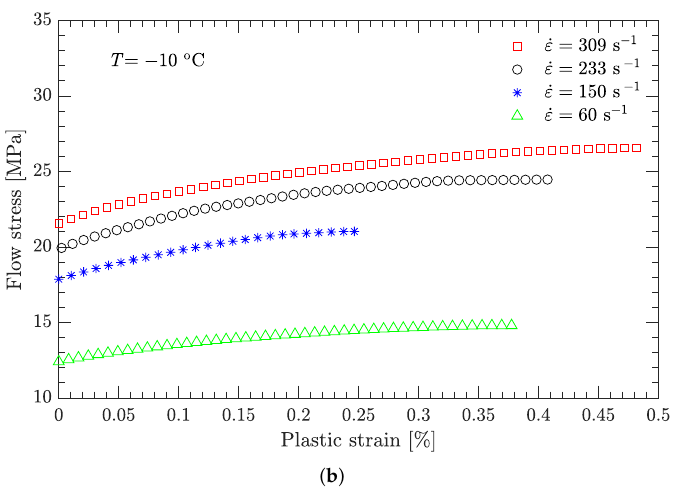
Figure 4. Measured flow stress vs. plastic strain at a temperature of − 10 ◦ C. ( a ) Static compression;